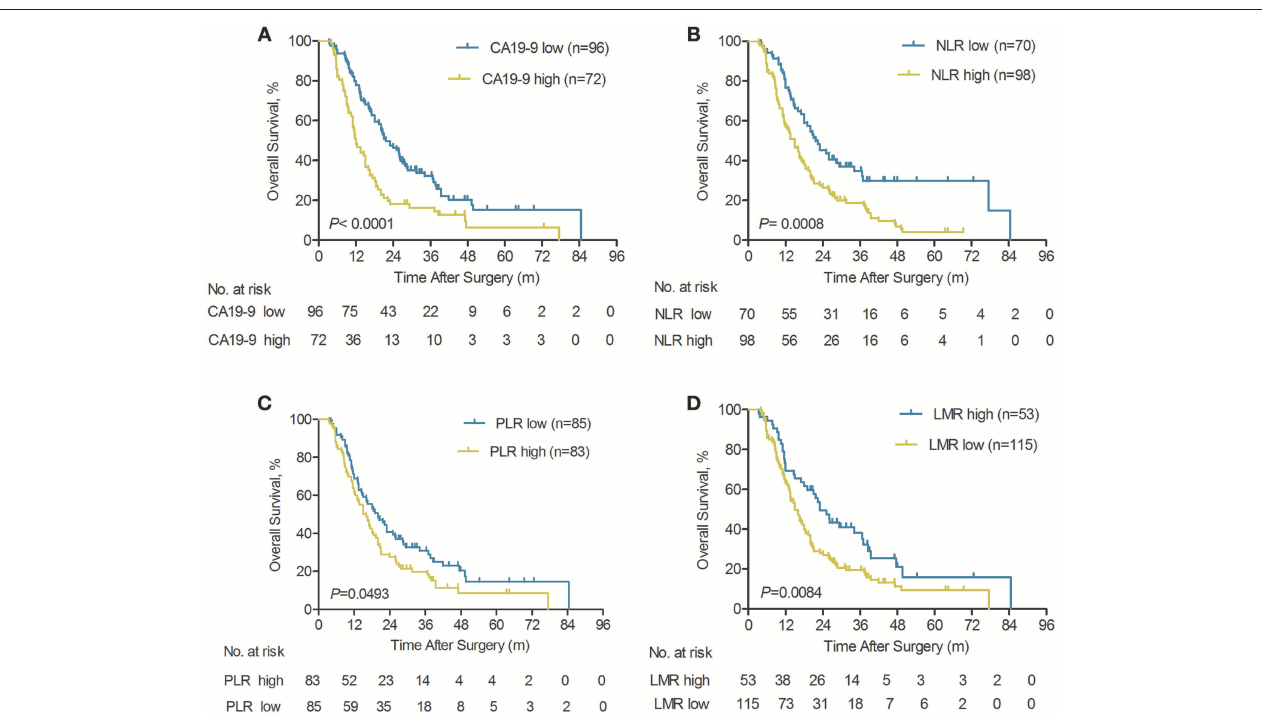
FIGURE 3 | Kaplan-Meier analyses of overall survival rate for ICC patients with early relapse according to serum CA19-9, pre-operative NLR, PLR, and LMR. (A) Compared with the serum CA19-9 high group, OS was significantly higher in the serum CA19-9 low group ( n = 168), P < 0.0001 (log-rank test). (B) Compared with the pre-operative NLR high group, OS was significantly higher in the NLR low group ( n = 168), P = 0.0008 (log-rank test). (C) Compared with the pre-operative PLR high group, OS was significantly higher in the pre-operative PLR low group ( n = 168), P = 0.0493 (log-rank test). (D) Compared with the pre-operative LMR low group, OS was significantly higher in the pre-operative LMR high group ( n = 168), P = 0.0084 (log-rank